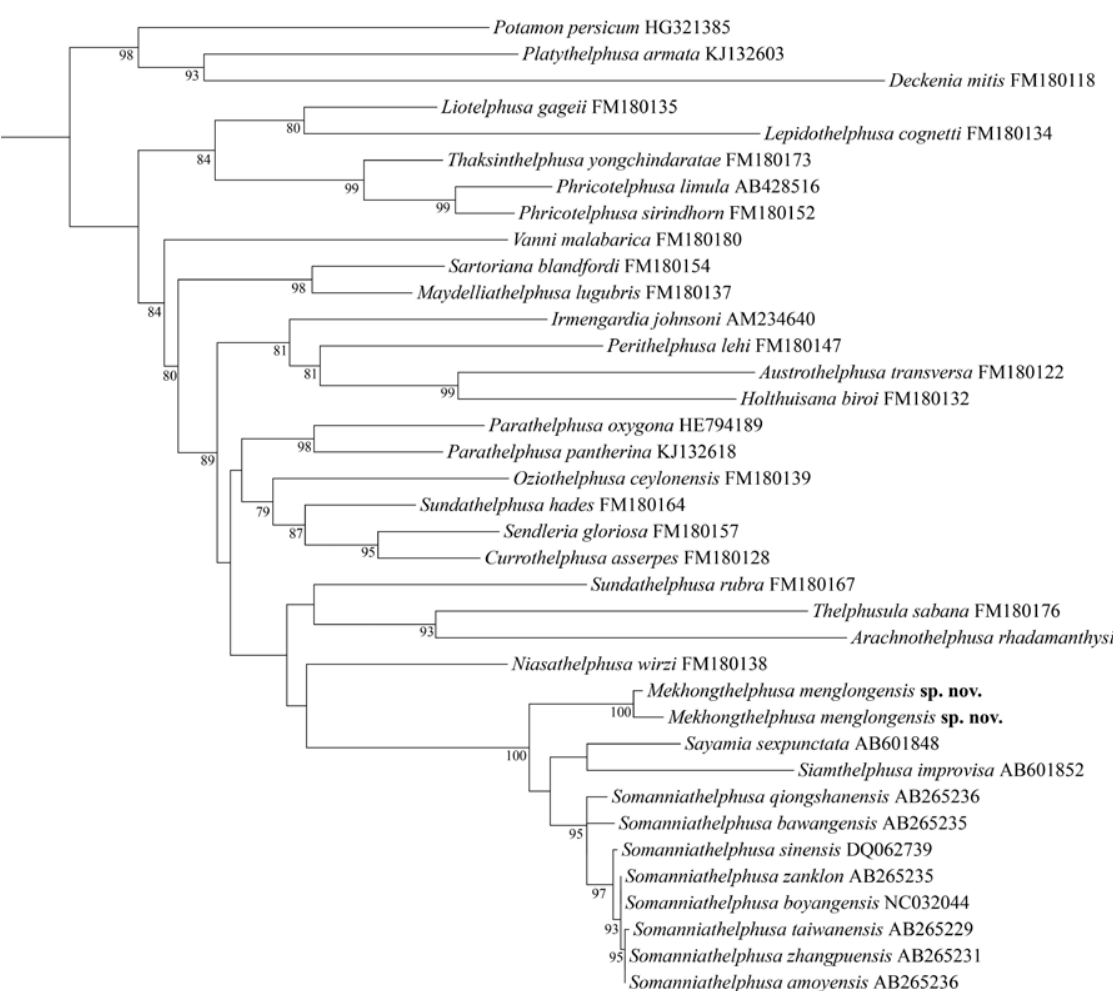
Figure 5. Maximum likelihood tree based on mitochondrial 16S sequences. The values on nodes are bootstrap support values (BS). Only BS above 70 are